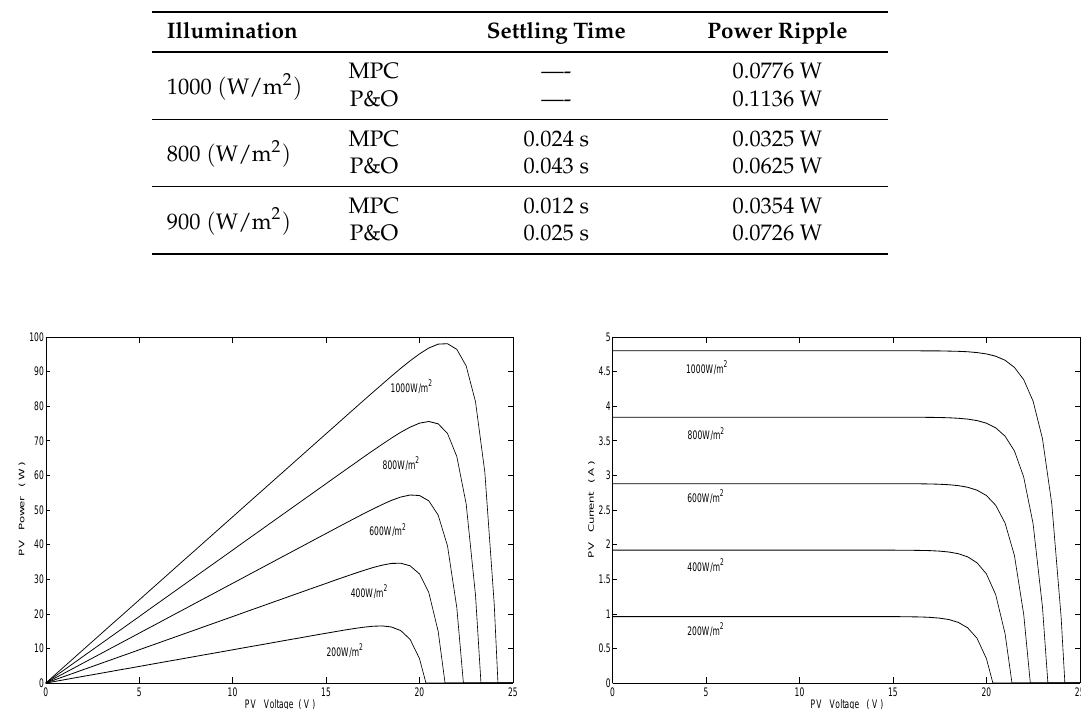
Table 1. The simulation data of PV module.